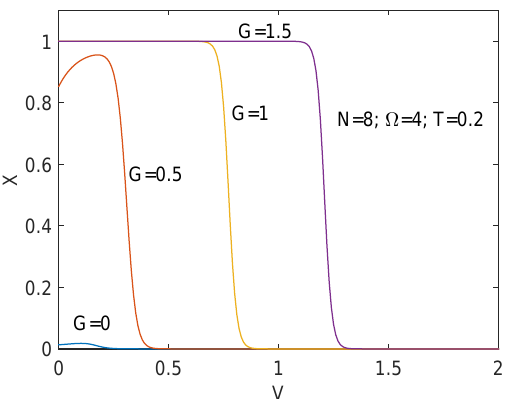
Figure 2. Superconductivity indicator X versus monopole coupling constant (cc) V for various values of the paring cc G . We have N = 8 and T = 0.2. Intense monopole forces destroy